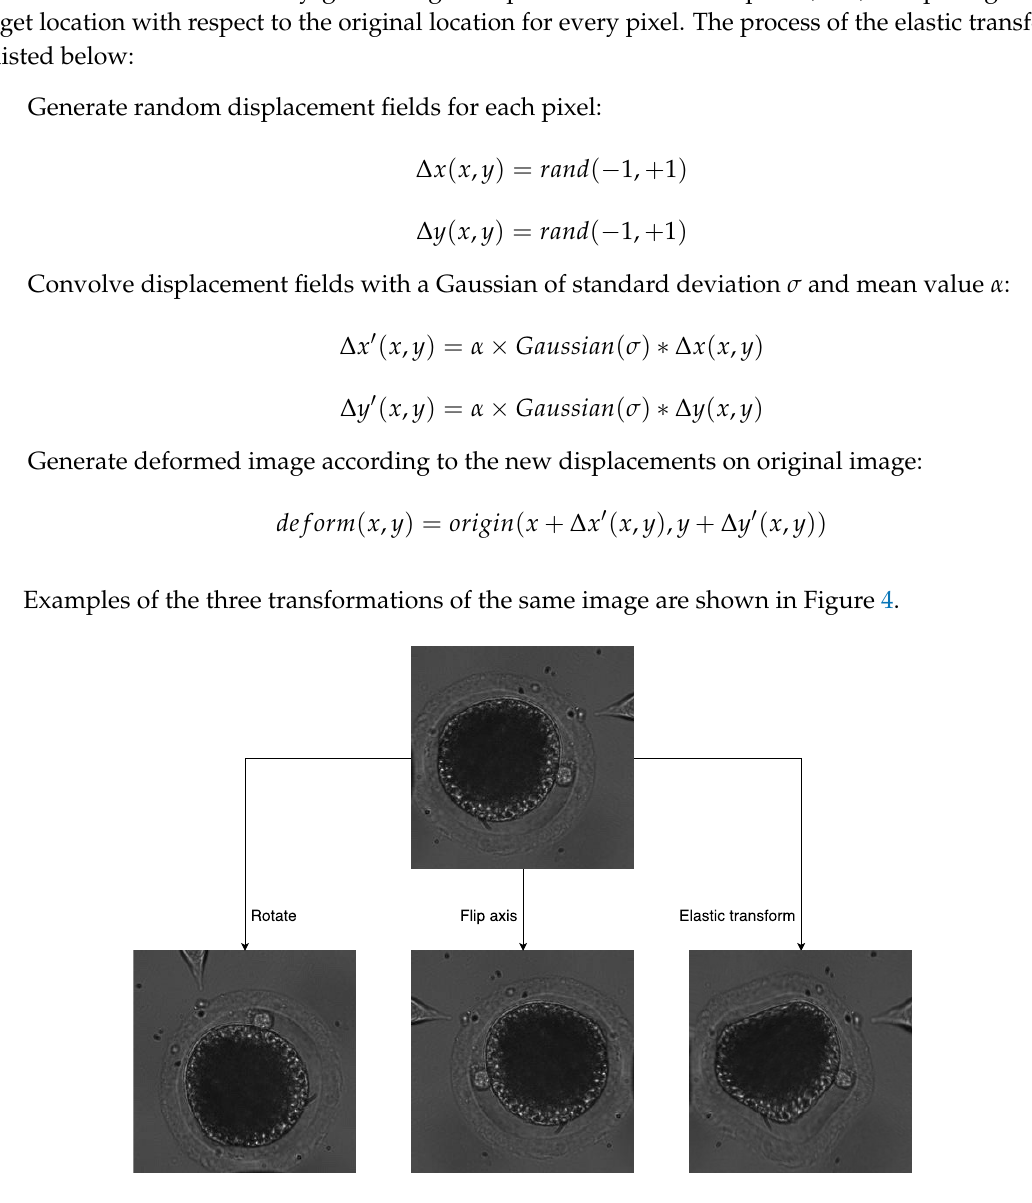
Figure 4. Three data-augmentation